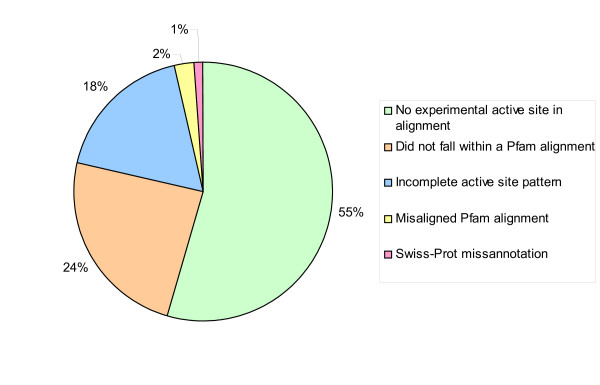
Breakdown of the UniProtKB predicted active sites that are not predicted using our methodology.